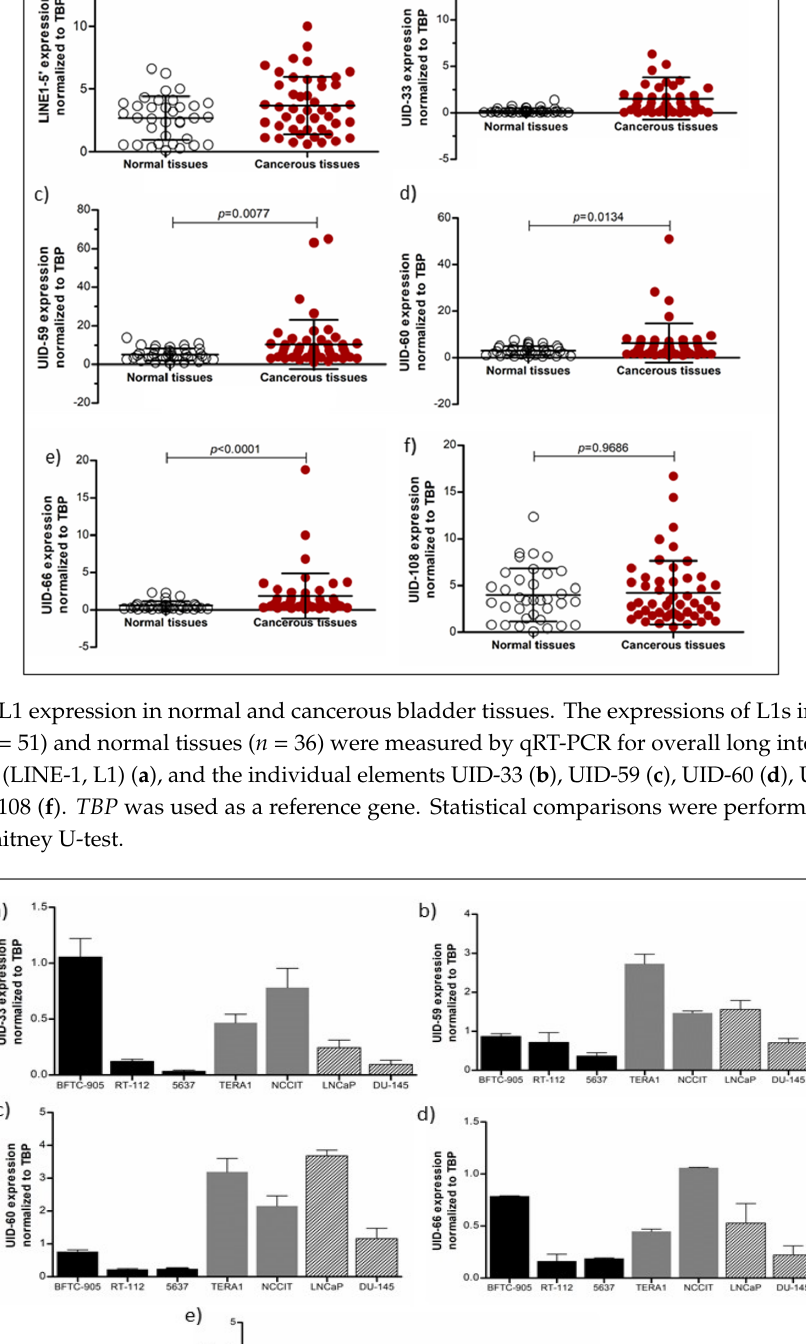
Figure 2. L1 expression across bladder cancer cells and normal urothelial cells. Measurements of RNA expression of overall LINE-1 (flL1) using the 5’-LINE1 assay ( a ) and the individual elements UID-33 ( b ), UID-59 ( c ), UID-60 ( d ), UID-66 ( e ) and UID-108 ( f ) were performed by quantitative real-time PCR. TBP was used as a reference gene.